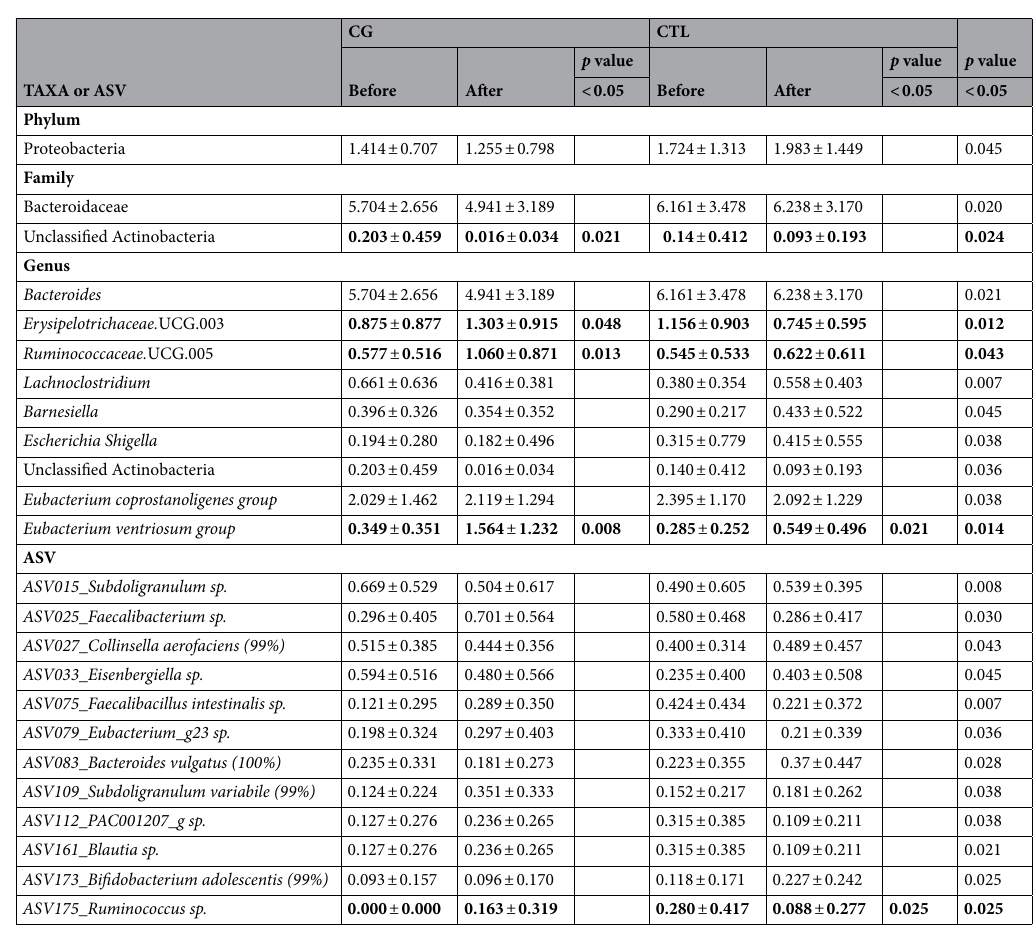
Table 3. Effects of chitin glucan compared to control on gut microbiota composition (n = 13). Data are expressed as mean percentage of relative abundance ± SD. To compare the shifts (i.e. the delta between the two treatments) and the baseline and endpoint, Wilcoxon signed-rank tests were performed and considered as significant if p < 0.05. Bacterial taxa with significant p inter- and intragroup are presented in bold. For ASV identification, species name are indicated when the identity is >